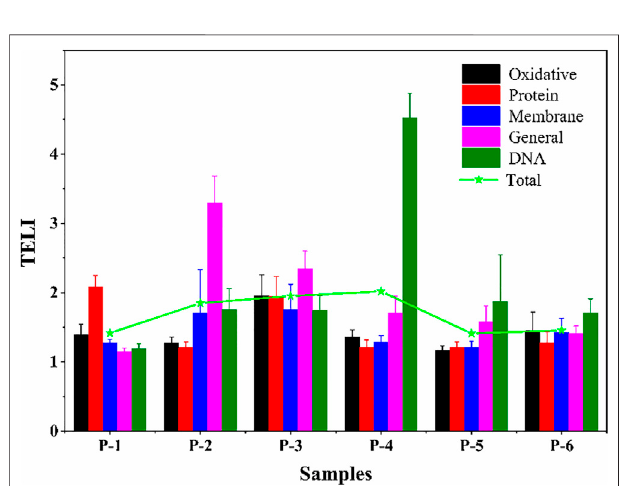
FIGURE 10 | Overall stress TELI responses in E. coli exposed to SUC treatedindifferentdisinfectionprocesses(P-1,P-2,P-3,P-4,P-5,andP-6are the same as in Figure 9